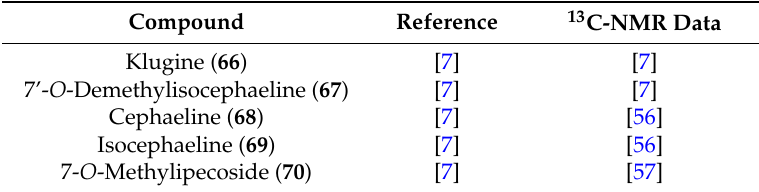
Table 5. Benzoquinolizidine Alkaloids from P. klugii .